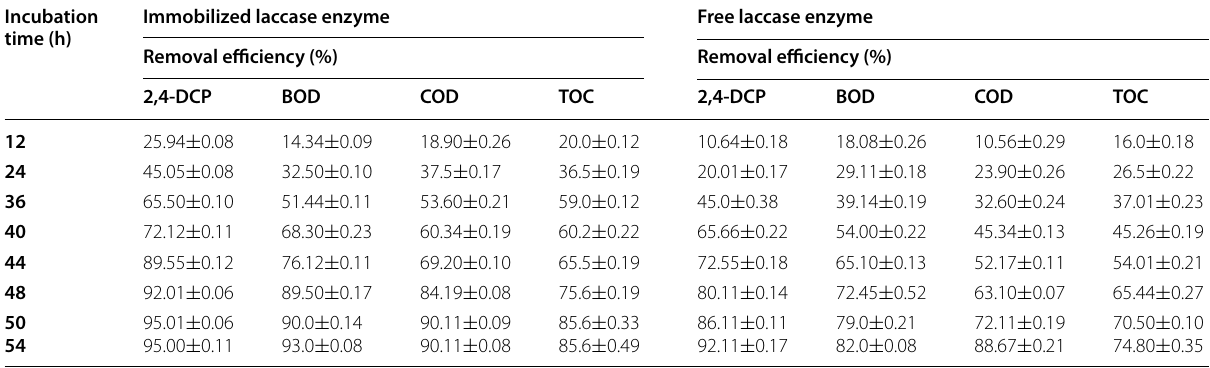
Table 4 Removal of some pollutants and 2,4‑DCP by free, immobilized laccase from wastewater sample. Data are expressed as mean standard deviation across technical replicates ( n ±